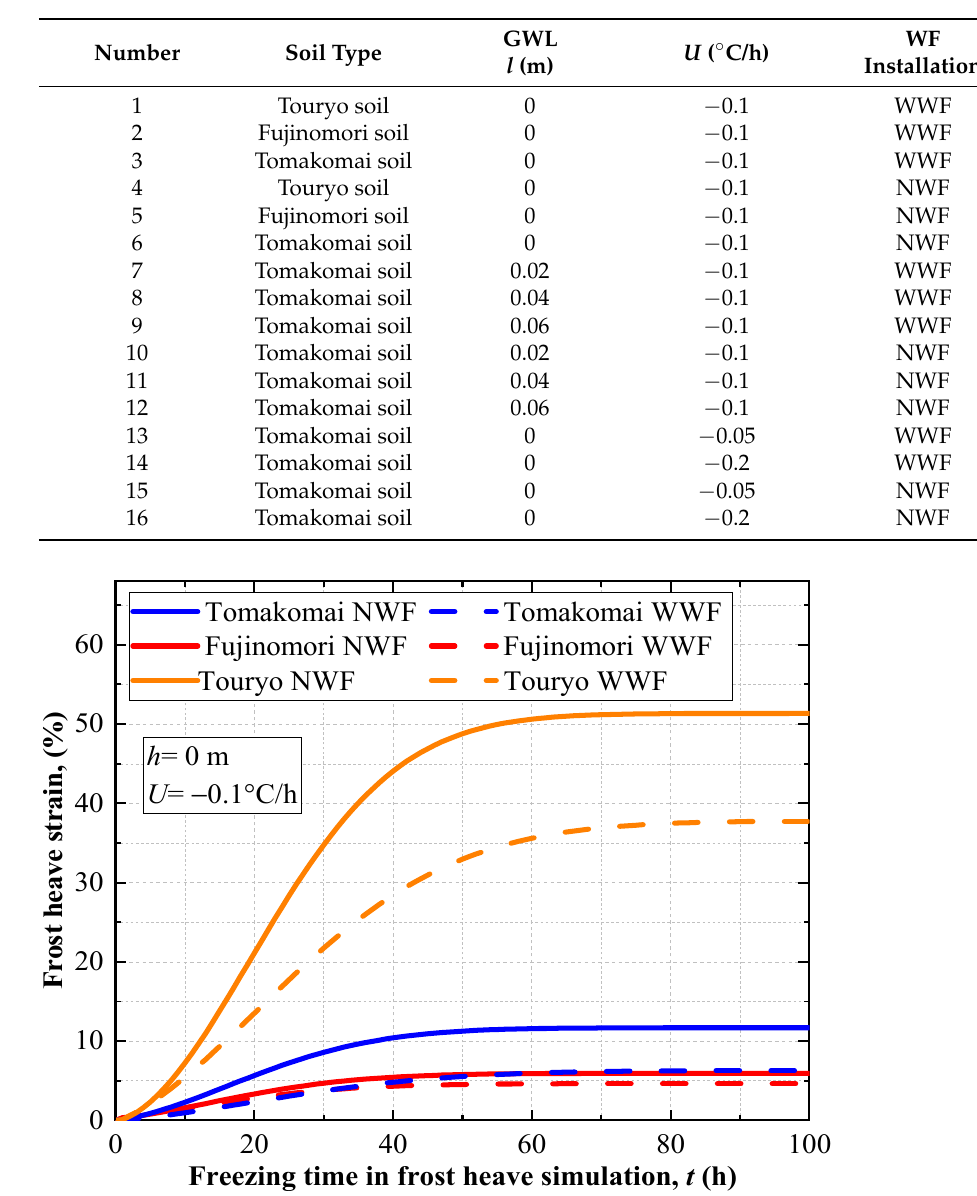
Table 5. Numerical simulation conditions.